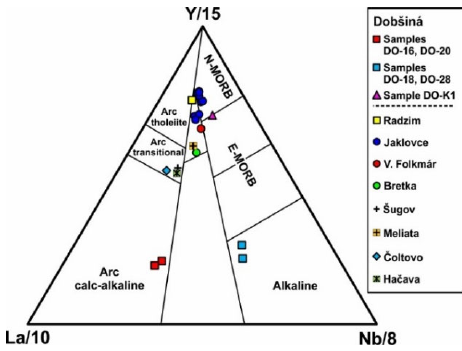
Figure 13. Geotectonic origin of the Meliatic metabasalts in diagram of [110]. Three groups of basalts were distinguished: (1) calc ‐ alkaline arc basalts (DO ‐ 16, 20), including transitional ones to arc tholeiites (SUG, HAC, COL), (2) alkaline (DO ‐ 18, 28), and (3) N ‐ MORB, including N ‐ MORB of BAB (a middle small triangle area).